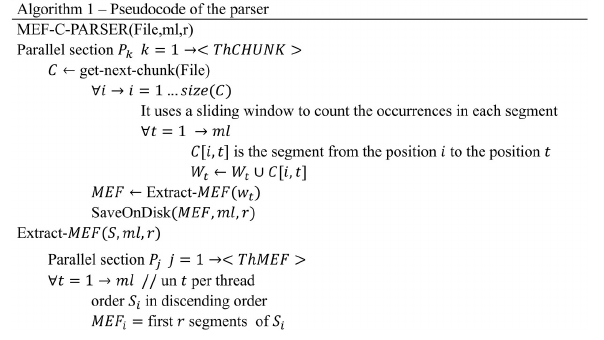
FIGURE 2 | Algorithm 1- Pseudocode of the